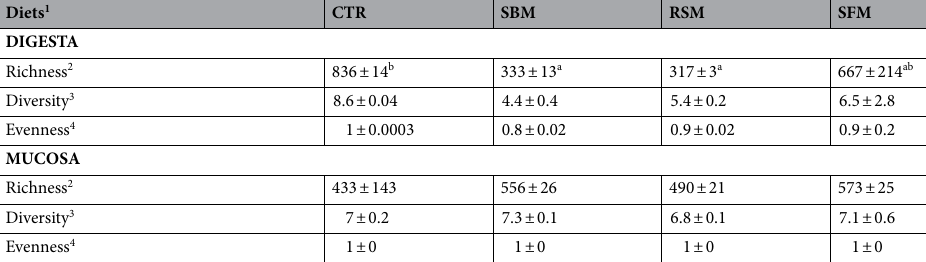
Table 2. Ecological parameters obtained from NGS analysis of the intestinal and mucosal microbiota recovered from European sea bass at 45 days after feeding the experimental diets (CTR, fishmeal based diet; SBM, soybean meal based diet; RSM, rapeseed meal based diet; SFM, sunflower meal based diet). Values presented as means ± standard deviation (± SD) (n = 3 per treatment pooled from 6 fish). One-way ANOVA: * p < 0.05. Different letters stand for significant differences between diets. 1 CTR, control fishmeal based diet; SBM, soybean meal based diet; RSM, rapeseed meal based diet; SFM, sunflower meal based diet. 2 Chao1 species richness: S Chao1 = S obs + n 12 /2n 2 , where S obs is nr of species, n 1 singletons , and n 2 doubletons. 3 Shannon’s diversity index: H’ = − ∑(Pi(lnPi)), whereas Pi is the nr of individuals of the ith species. 4 Simpson’s Evenness Index: E = (1/∑Pi2)/S, where S is ty number of